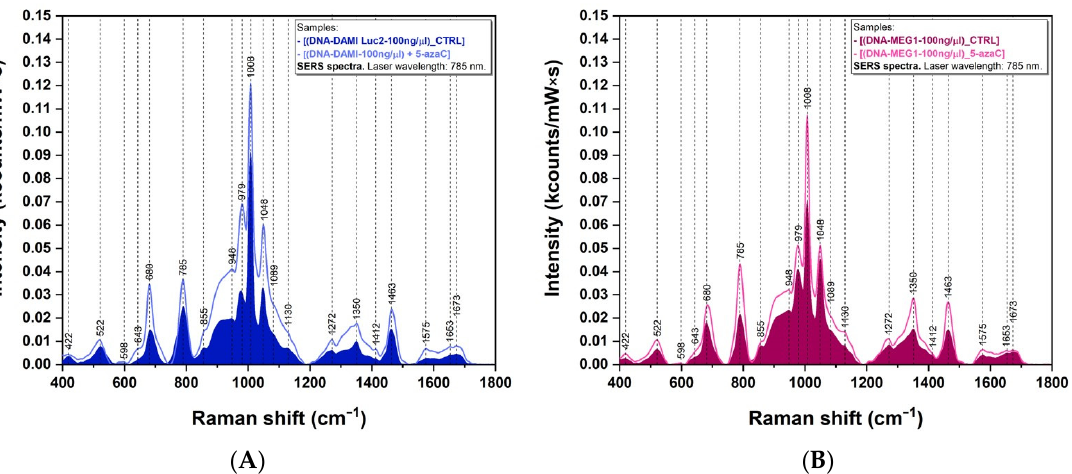
Figure 5. SERS spectra of DNA samples collected from DAMI Luc2 ( A ) and MEG-1 ( B ) cells before (filled area) and after treatment with 5-azaC; recorded using a 785 nm laser.